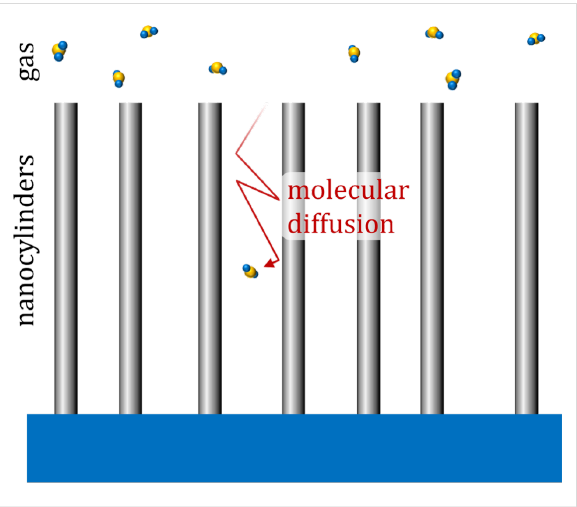
Figure 1: Schematic of an array of randomly distributed vertically aligned high-aspect-ratio nanocylinders. The gas is dilute, therefore collisions between molecules within the nanocylinder array can be neglected. Reflections of molecules from the walls are diffusive (cosine distributed).